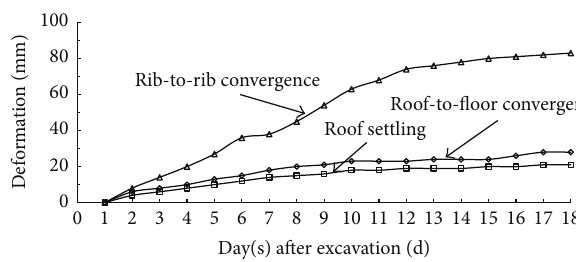
Figure 17: Roadway deformation after excavation versus time.